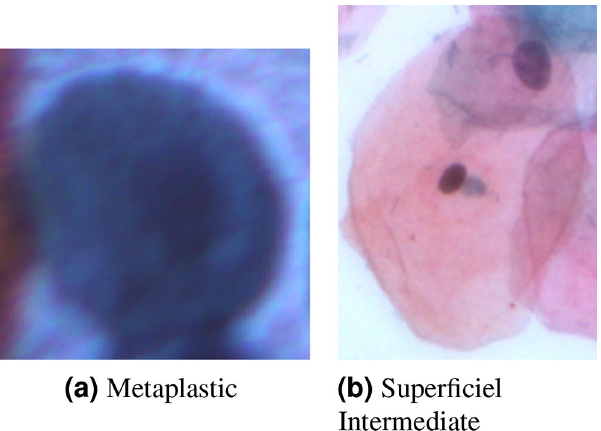
Figure 17. Examples of some misclassified samples from the SIPaKMeD Pap Smear dataset 9 . (a) Final prediction: “Parabasal” (b) Final prediction: “Koilocytotic”.